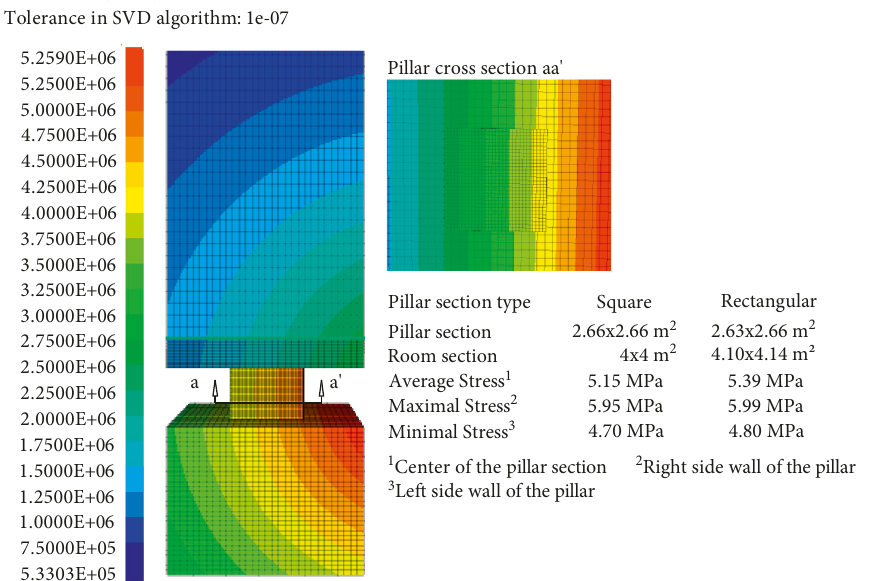
Figure 5: Dynamic stresses in the square and rectangular pillar section.